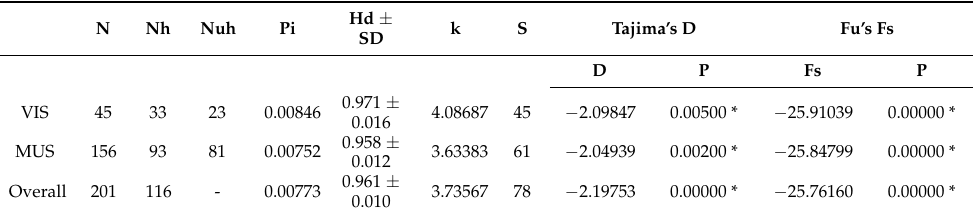
Table 6. Genetic diversity indices and neutrality test based on mtDNA cox2 sequences of A. simplex from viscera (VIS) and muscle (MUS) of European hakes.